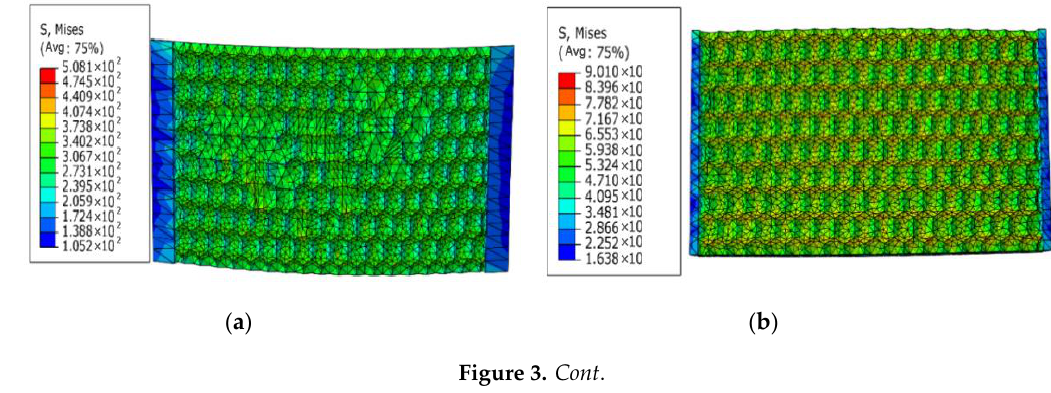
Figure 2. Constraints and loads imposed by the model: ( a ) constraints imposed, ( b ) application of load.